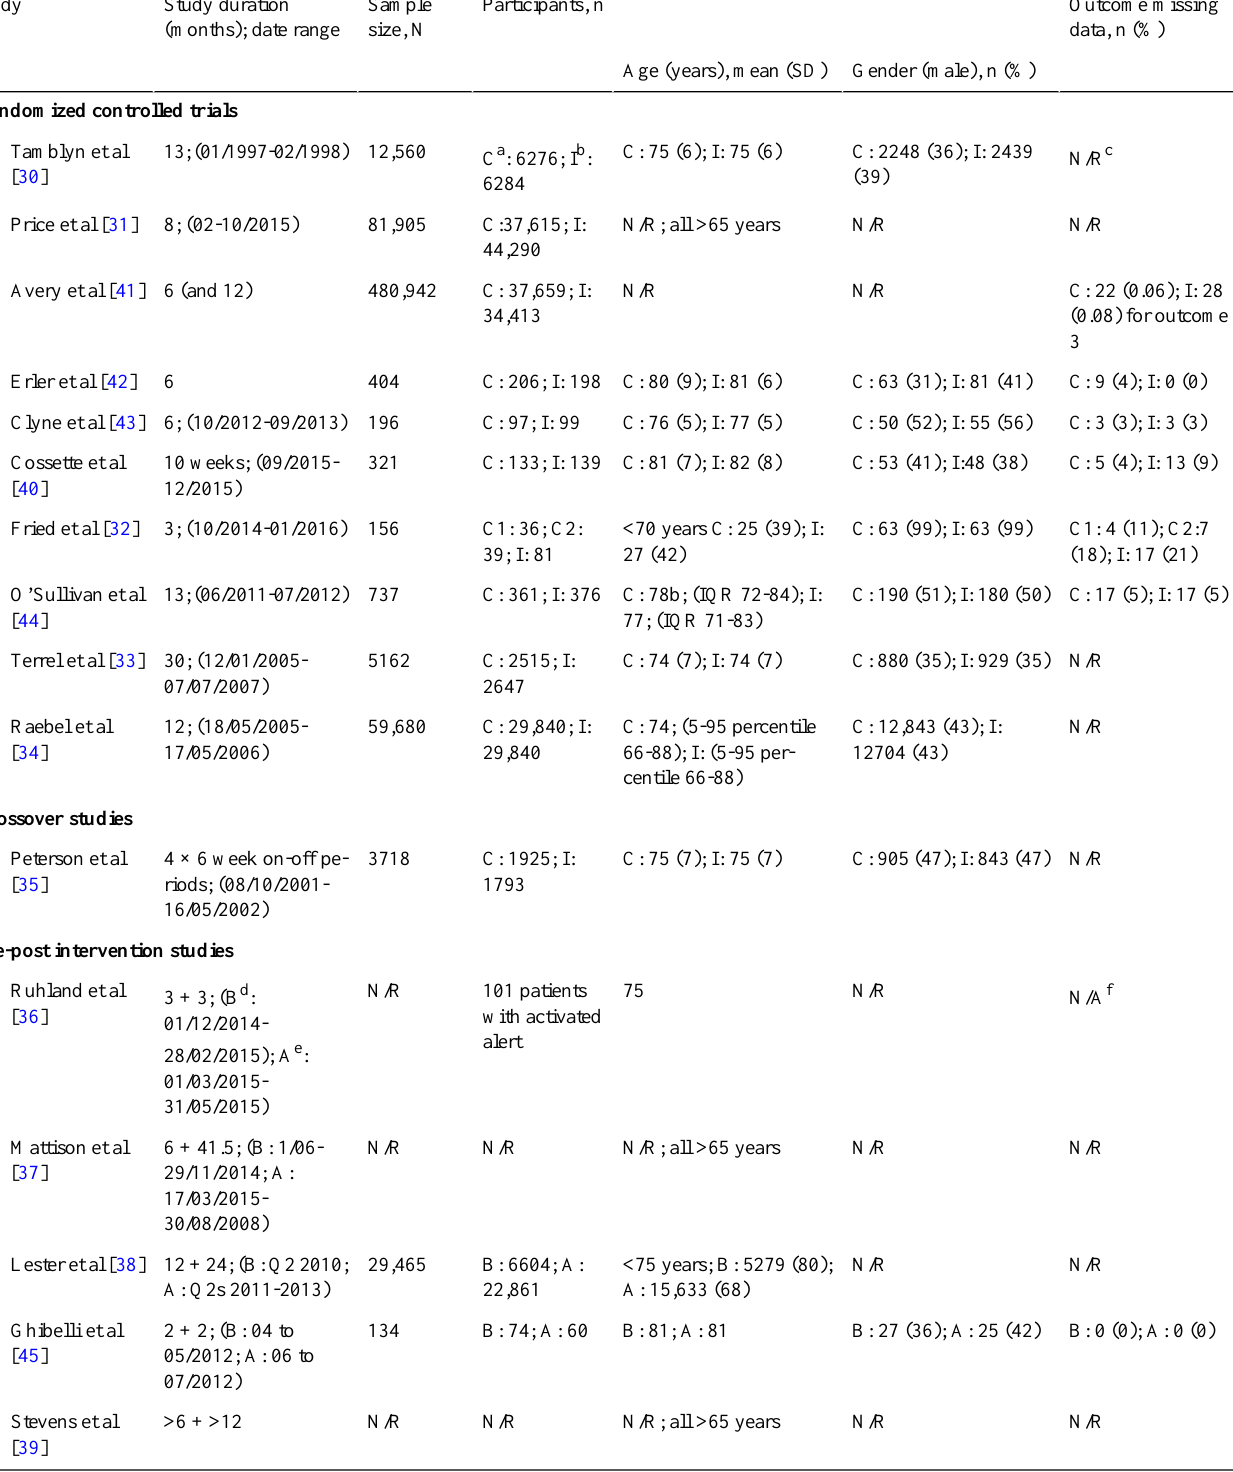
Table 2. Characterization of the included studies in the systematic review, including study type, study duration, sample size, and participant demographics